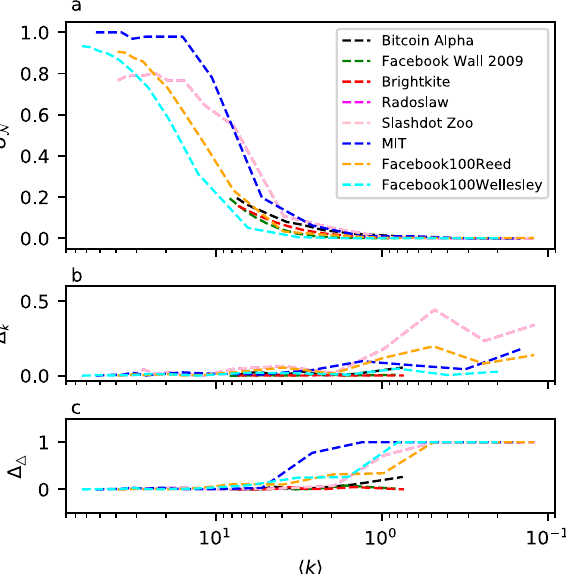
Figure 4. Results for 8 networks listed in Table 1 after uniform random edge-sampling, i.e., when a fraction of randomly chosen edges are removed. The horizontal axis indicates the average degree (cid:31) k (cid:30) of the networks after sampling (removal of random edges). The sampling rate is varied between no links being removed (where the average degree is that of the original network) and a rate which yields a low enough average degree such that we reach zero uniqueness ( U N = 0 ). The curves start from the average degree value of the original network. ( a ) Effect of uniform edge sampling on the value of U N (on the vertical axis): as we sample edges, the values of the average degree (cid:31) k (cid:30) gets lower as well; ( b ) error of the estimation of the degree of the nodes (average over all the nodes in the network) in the networks with Eq. (10); ( c ) error of the estimation of the amount of triangles in the networks with Eq. (11). The error in these estimates is the difference, in absolute value, between the original value and the estimated